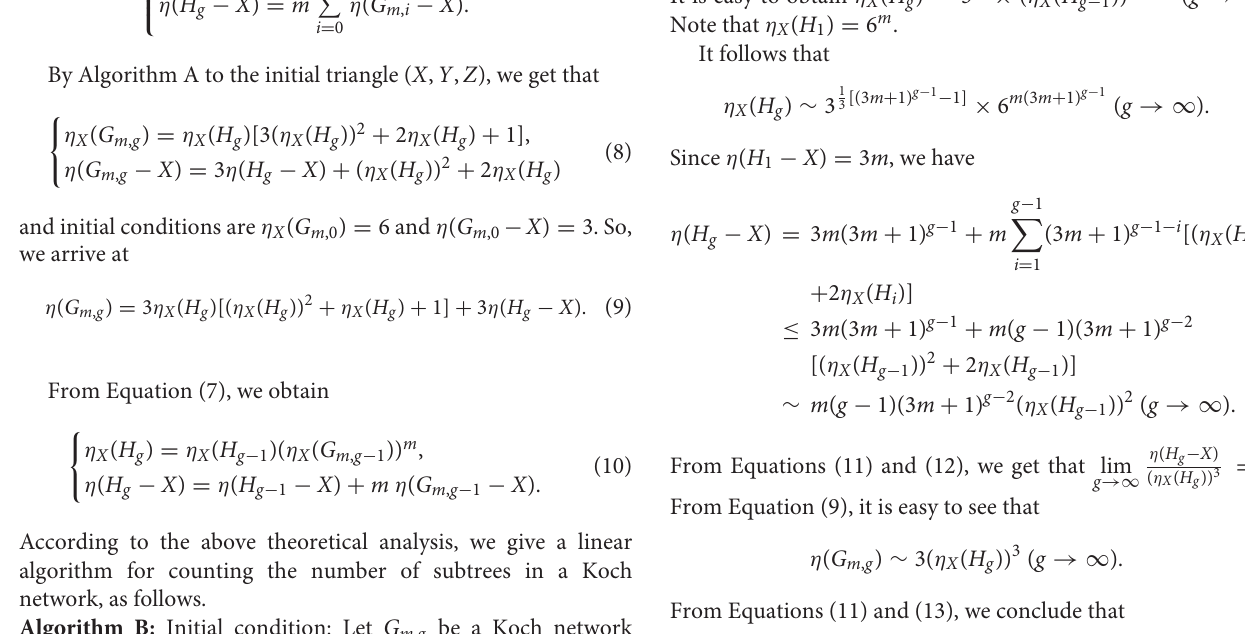
algorithm for counting the number of subtrees in a Koch network, as follows. Algorithm B: Initial condition: Let G m , g be a Koch network generated by g iterations and X , Y and Z be three hub vertices in G m , g . Let η ( G m , g ) denote the number of subtrees of G m , g